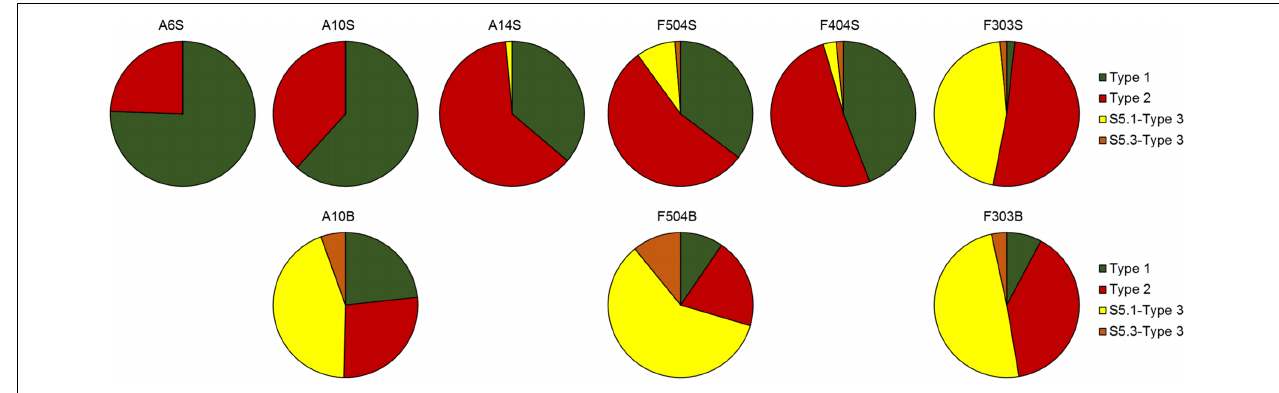
FIGURE 6 | Synechococcus pigment compositions in the surface and bottom samples revealed by sequencing the cpcBA operon sequences.